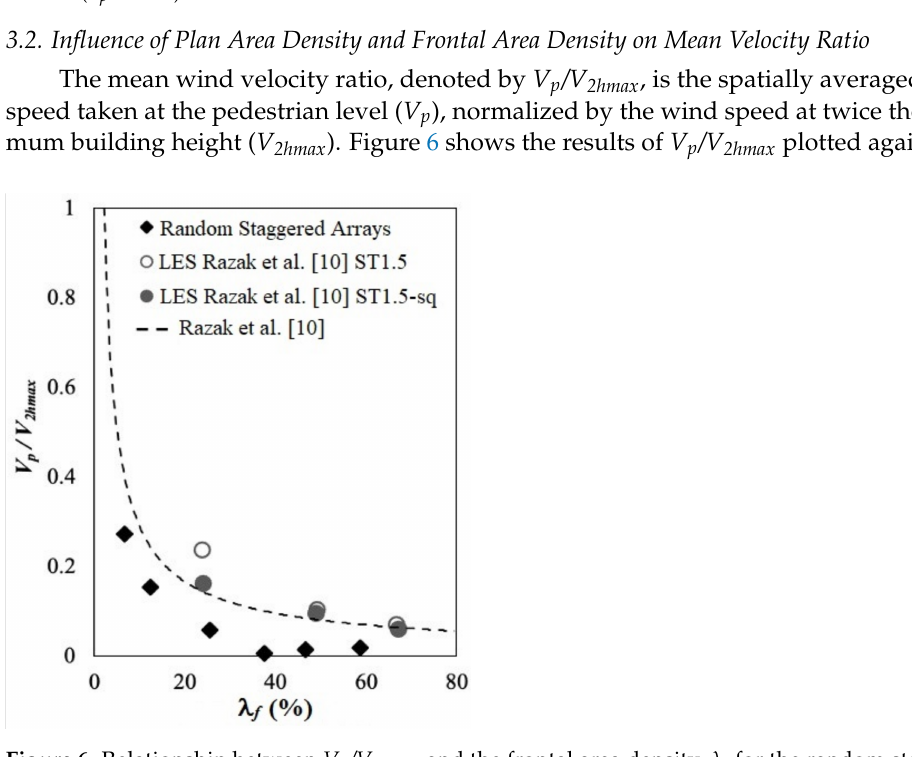
Figure 5. Mean wind velocity distribution along the vertical cross-section at y = 0.12 m for R39A ( λ p = 0.39). The arrow indicates the wind direction and the targeted buildings shown are B2 ( α p = 0.84) and B9 ( α p = 3.76).